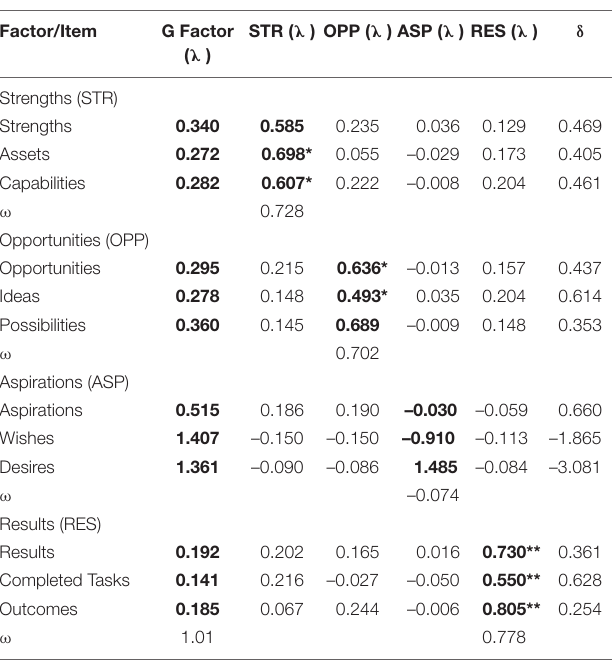
TABLE 5 | Standardized parameter estimates from the bifactor ESEM solution (Model